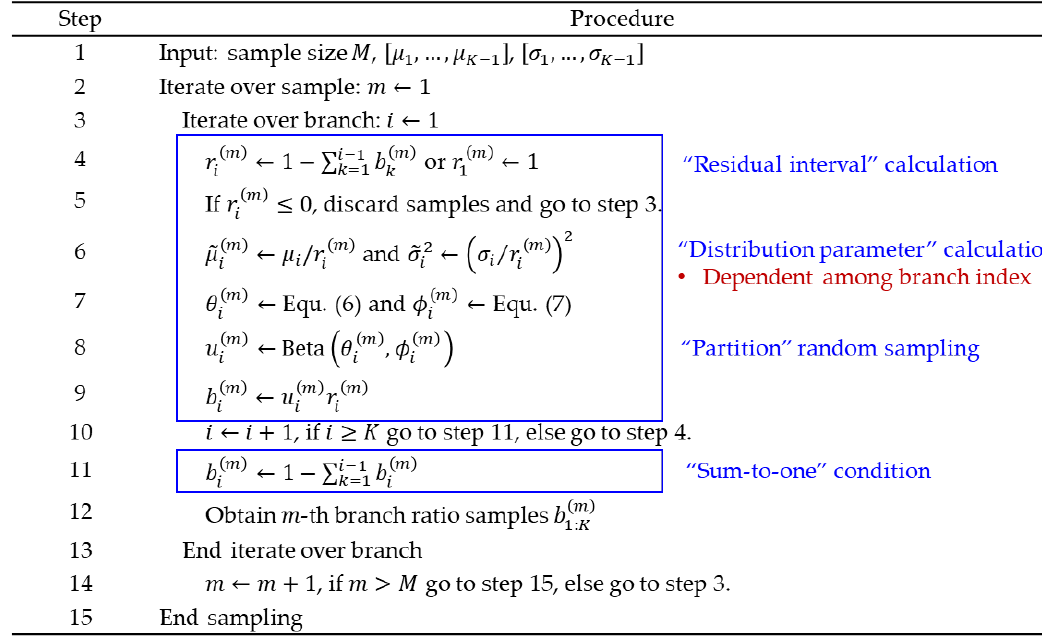
Figure 2. Sampling procedures in DIR sampling method.